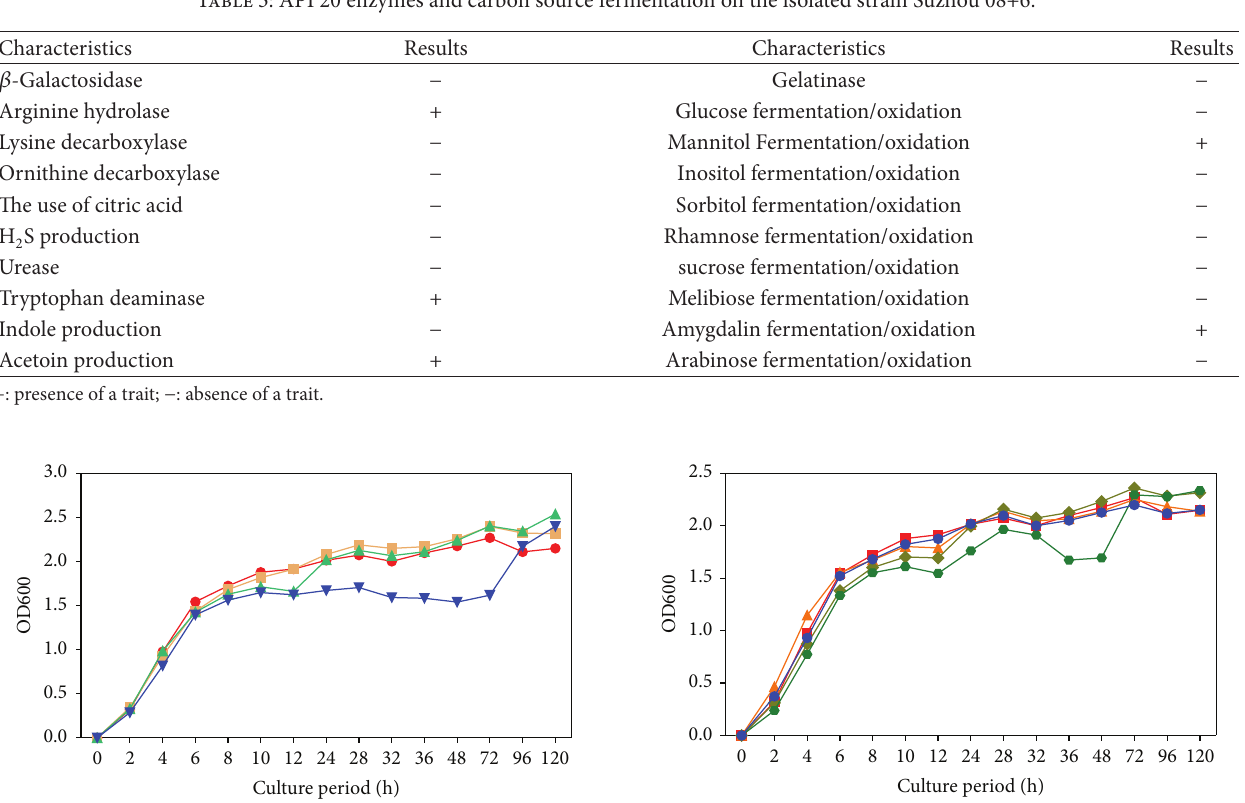
Table 3: API 20 enzymes and carbon source fermentation on the isolated strain Suzhou 08+6.